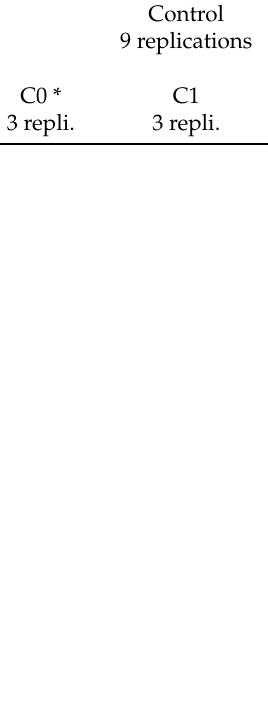
Table 1. Experimental design. First Factor: Cereal Grain ( n = 27)